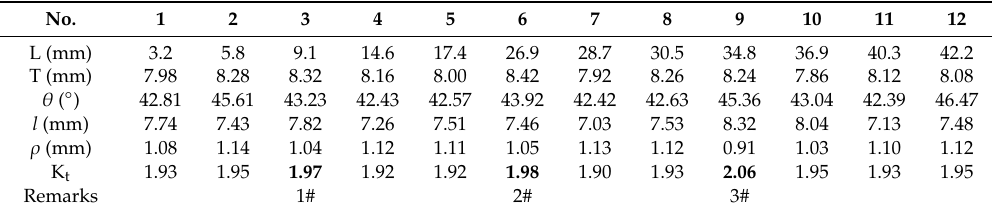
Table 4. Description of testing points.